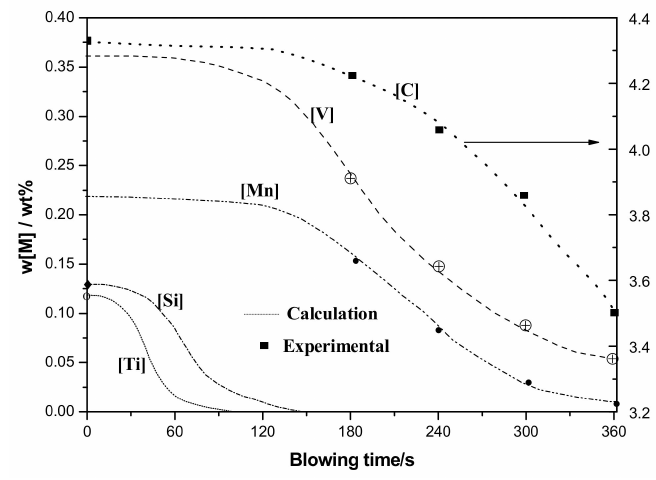
Figure 2. Variations of element content in hot metal.